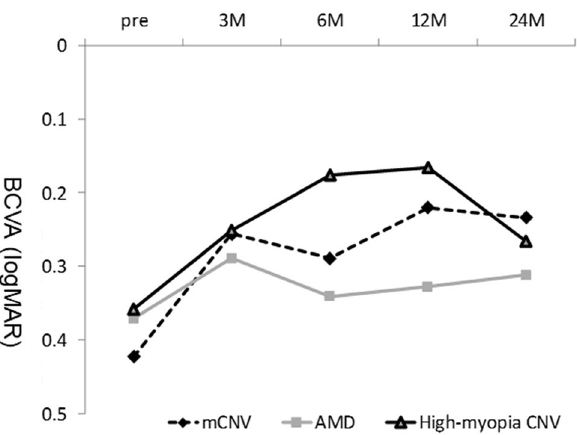
Figure 2. The average VA course of the mCNV, high-myopia CNV, and AMD groups. M, months; logMAR, logarithm of the minimum angle of resolution.